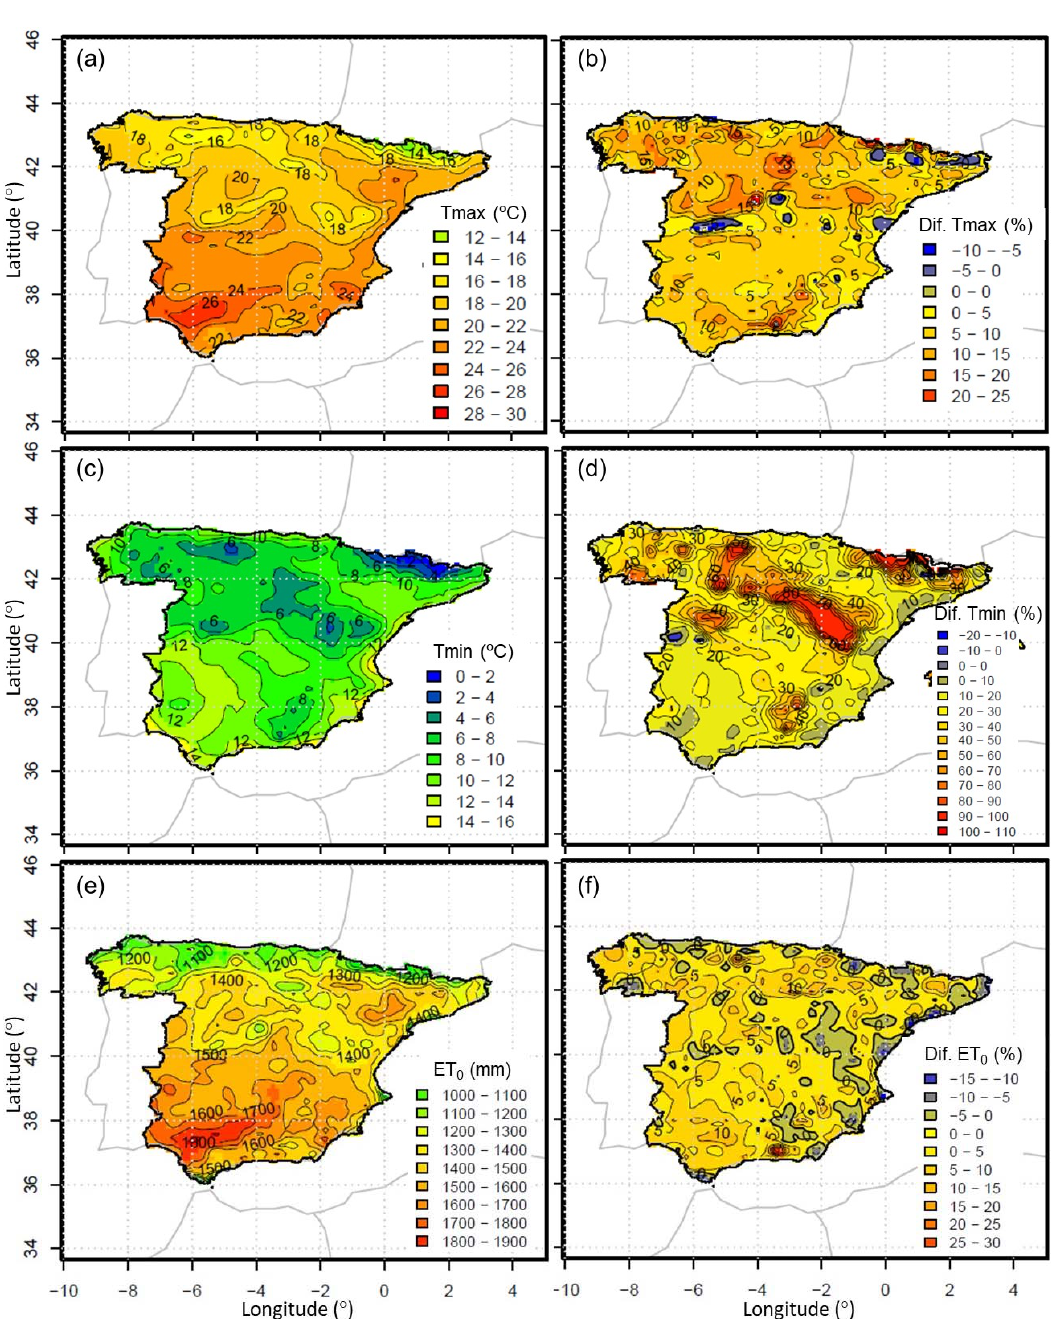
Figure 5. Spatial distribution of: ( a , c , e ) ensemble of mean annual maximum and minimum temperature, and ETo from RCMs for period 2021–2050; and, ( b , d , f ) Difference maps (%) between the periods 2021–2050 and 1961–1990 observational dataset, assessed as [100 × (mapEns − mapObs)/mapObs].